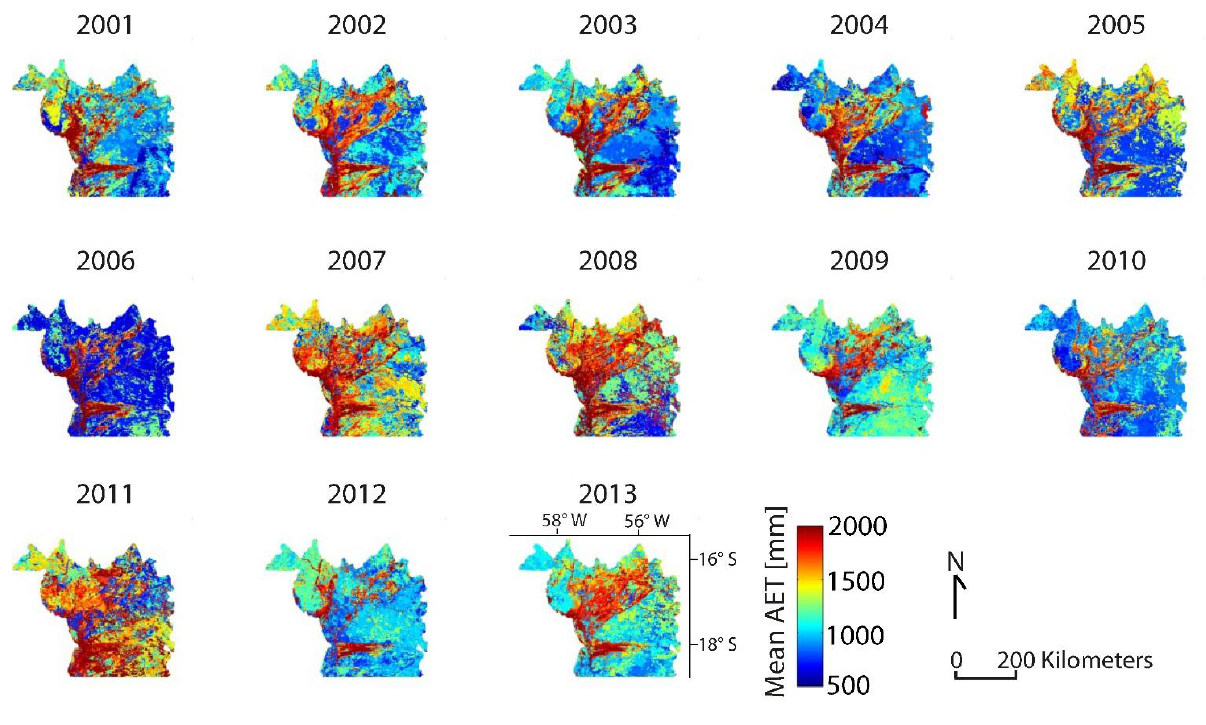
Figure 6. Simulated hydroperiods [days] for the years 2001 to 2013, where the map area corresponds to the Pantanal area located inside the MODIS tile (Figure 1a).